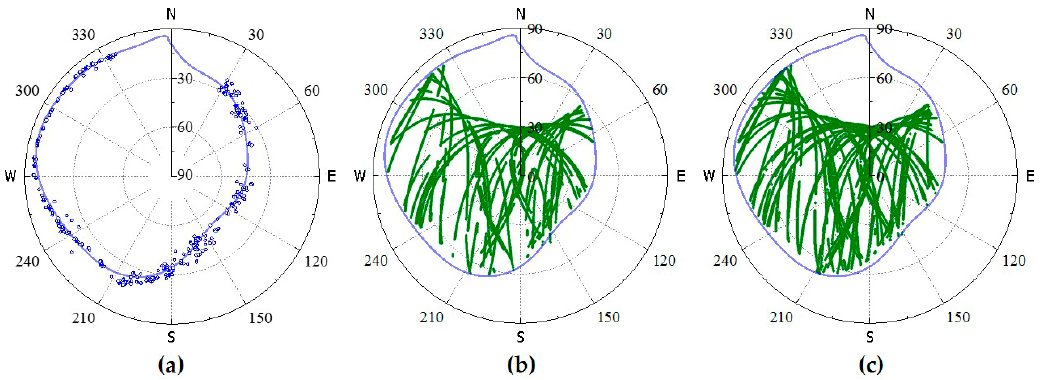
Figure 7. ADEM model fitted by the polynomial method and the compared sky view of satellites: ( a ) Initial and terminal point and fitted line; ( b , c ) the sky view of satellites at DOY 045 and 072, respectively.